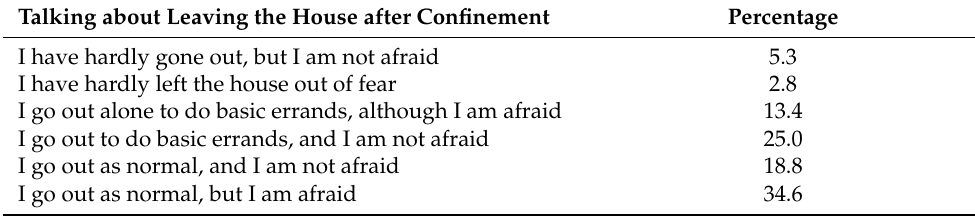
Table 2. Percentage distribution of the question about leaving the house.